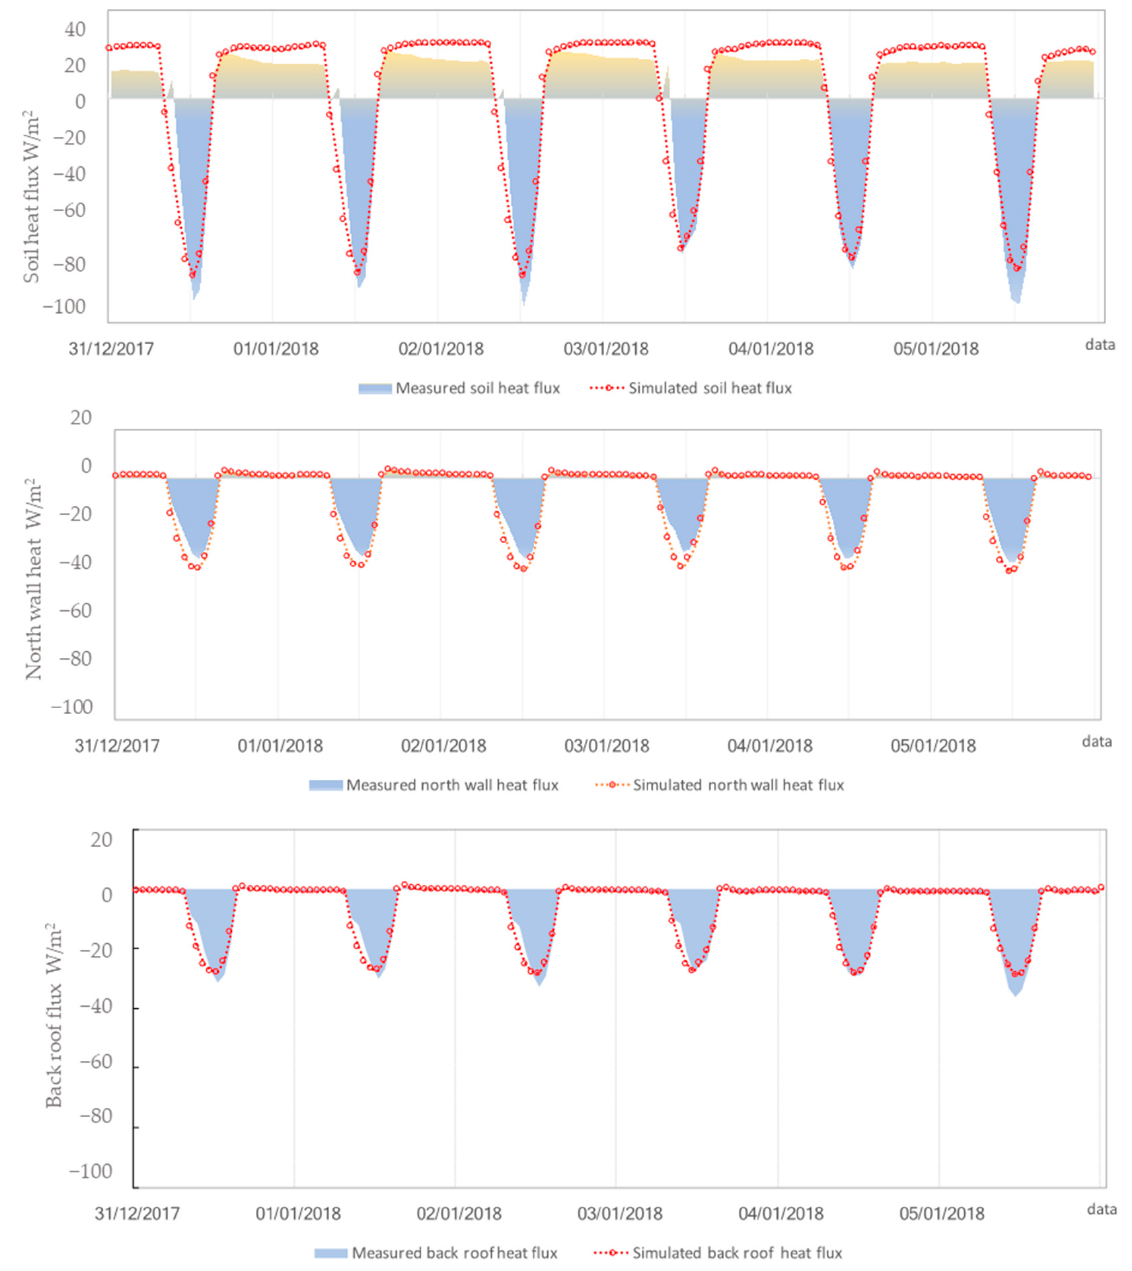
Figure 17. Comparisons of simulated and measured heat flux variations during clear days.